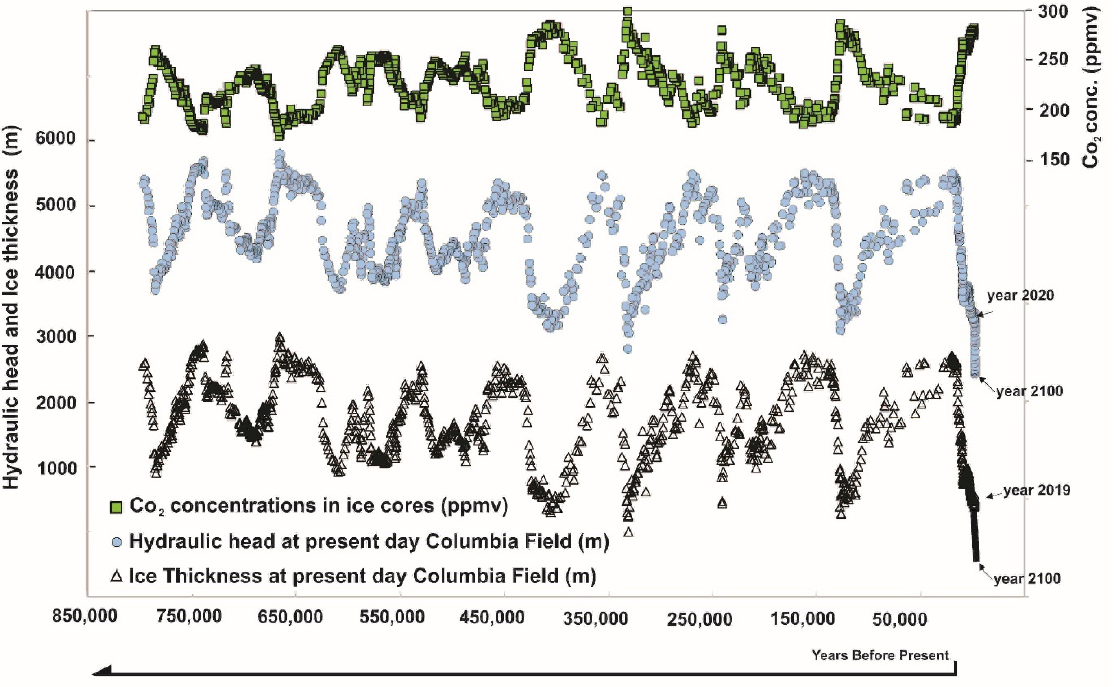
Figure 9. CO 2 concentrations from ice cores (ppmv), inferred ice height (m) at present day Columbia Ice Field, and inferred hydraulic head at Present Day Columbia Ice Field from 800,000 years ago until 2100. Based on Barnola et al. [32]; Refs [31,33–36]; Marshall et al. [37]; and Peltier et al. [38]. Based on Clarke’s study of projected deglaciation between 2015 and 2100 over the CRM (Clarke et al. [15]), the simulation was extended to the year 2100.